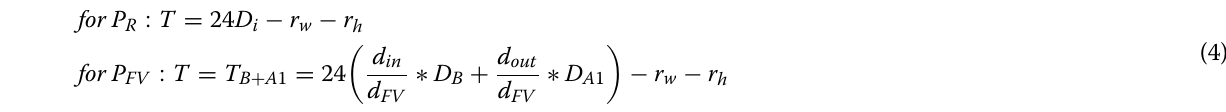
* For the Danube case all apprentice positions are considered to be a boatman